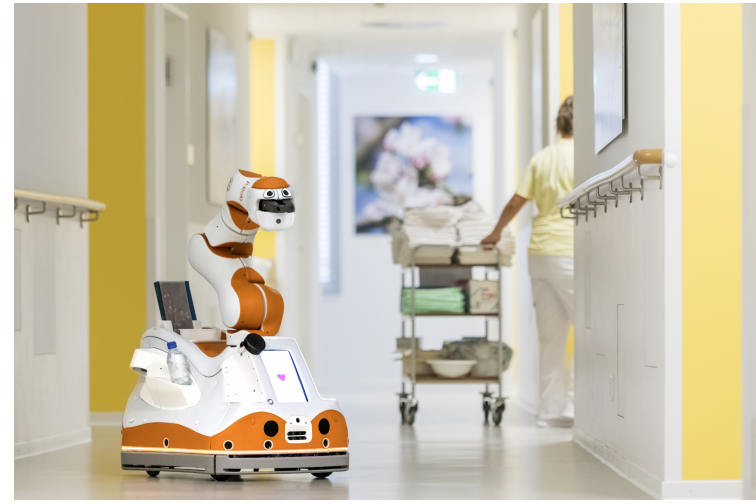
Figure 6. Lio [49].